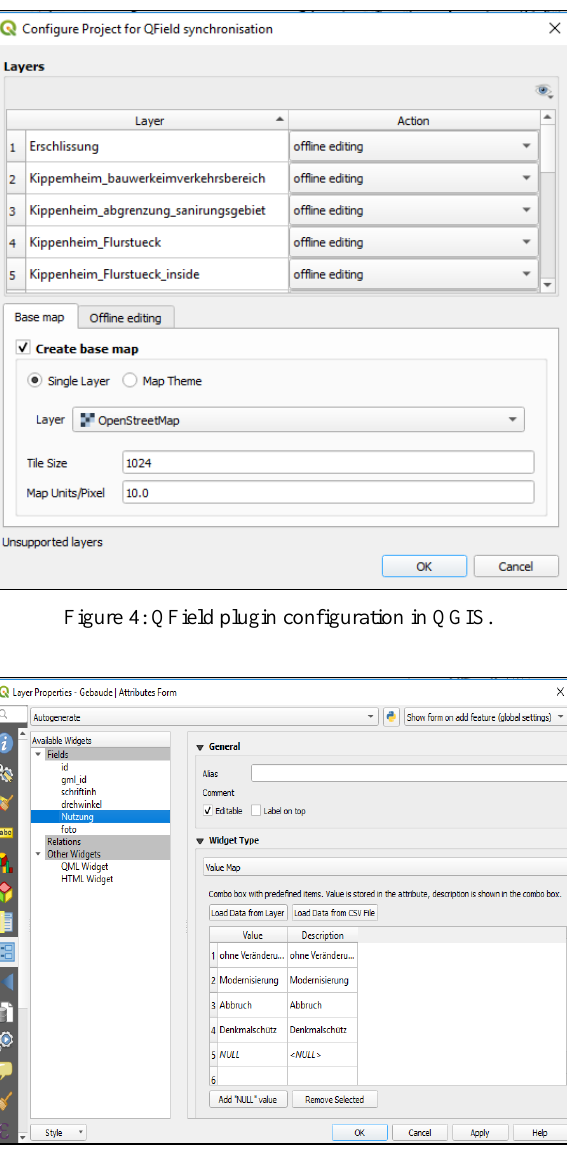
Figure 5: The form section of the layer properties in QGIS enables to define widget